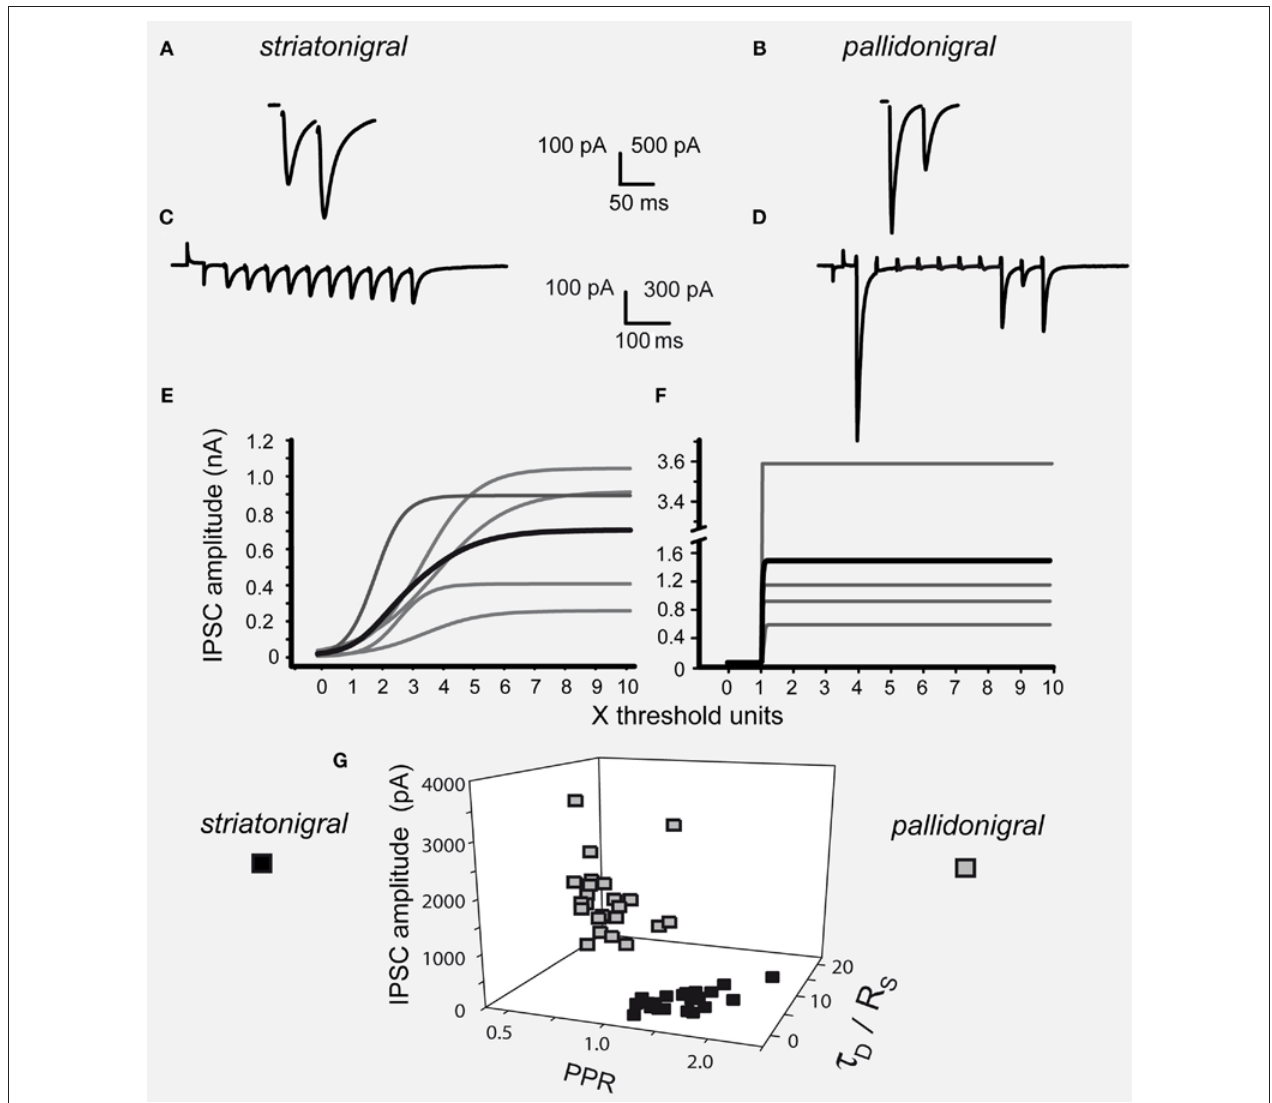
maximal amplitude after reaching threshold. I–A plots were fitted to: AI A e kI Ih ( ) /( ( ) = + − − 1 where A(I) = IPSC amplitude as a function of stimulus intensity, A = maximal amplitude reached, k = slope factor, and I = stimulus max h intensity necessary to reach IPSC amplitude equal to half maximal amplitude. All parameters were significantly different. (g) Cluster plot showing that IPSCs from these sources can be separated. PPR = paired-pulse ratio. τ = decay time D constant of IPSCs. R = rise time of S